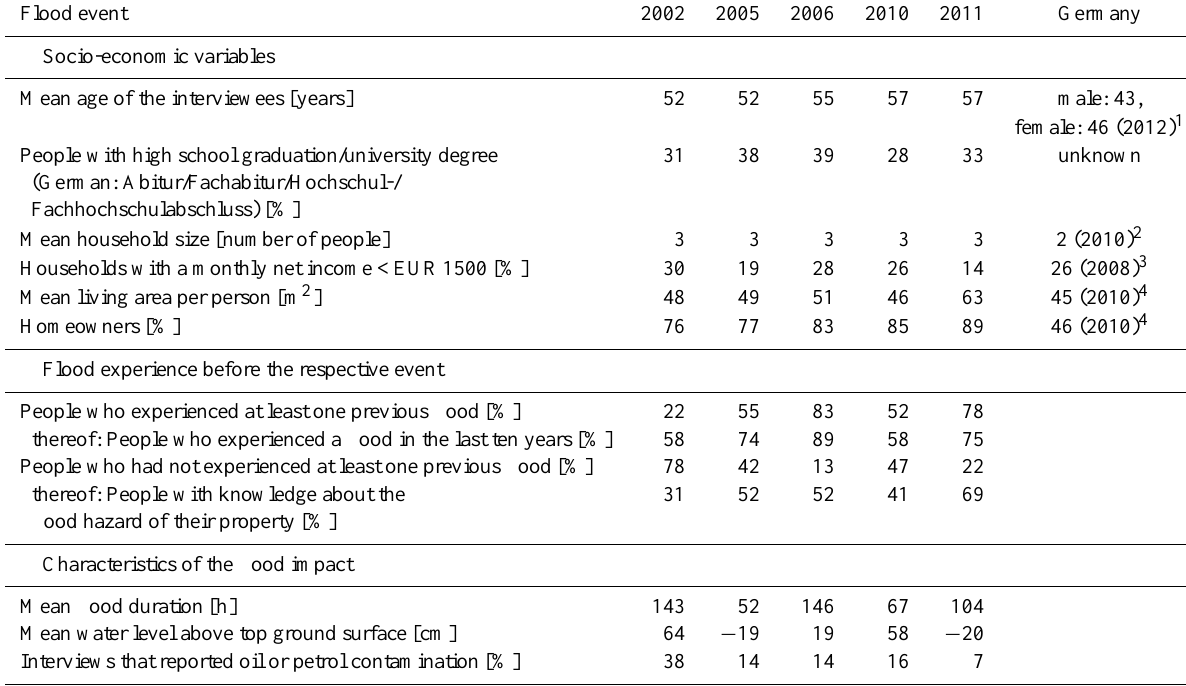
Table 5. Description of the different flood events with respect to socio-economic variables, previously experienced floods and flood impact (figures do not refer to all interviews, but to the respective number of valid